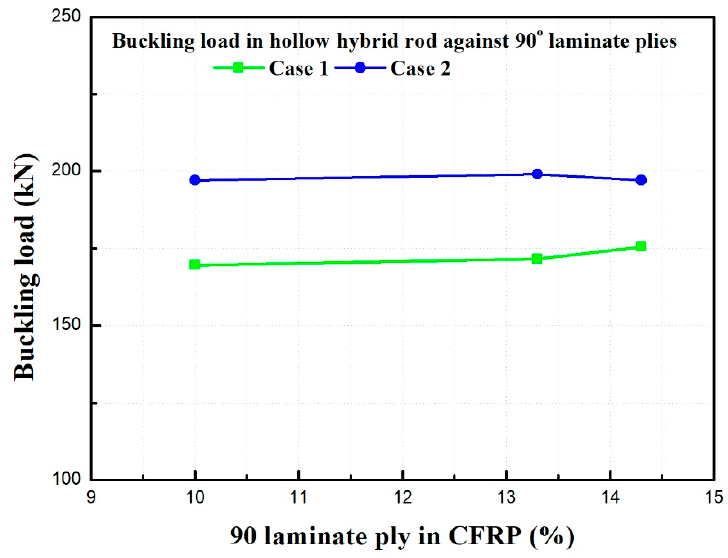
Figure 18. Change in buckling load as a function of percentage of 90° laminate in CFRP.